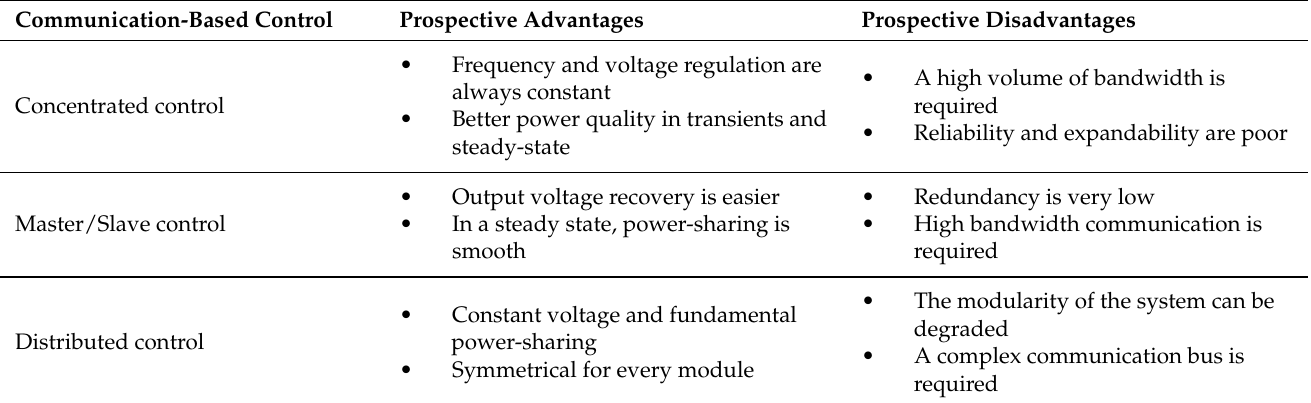
Table 8. Prospective advantages and disadvantages of the communication-based control techniques.